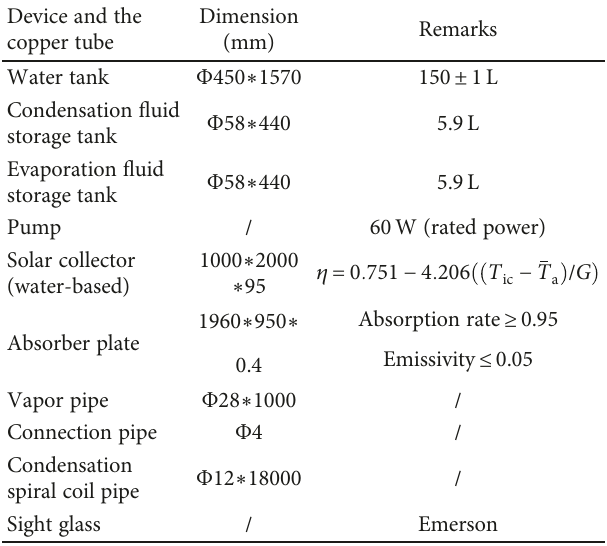
Table 1: Detailed information of the parts and the copper pipes. Device and the copper